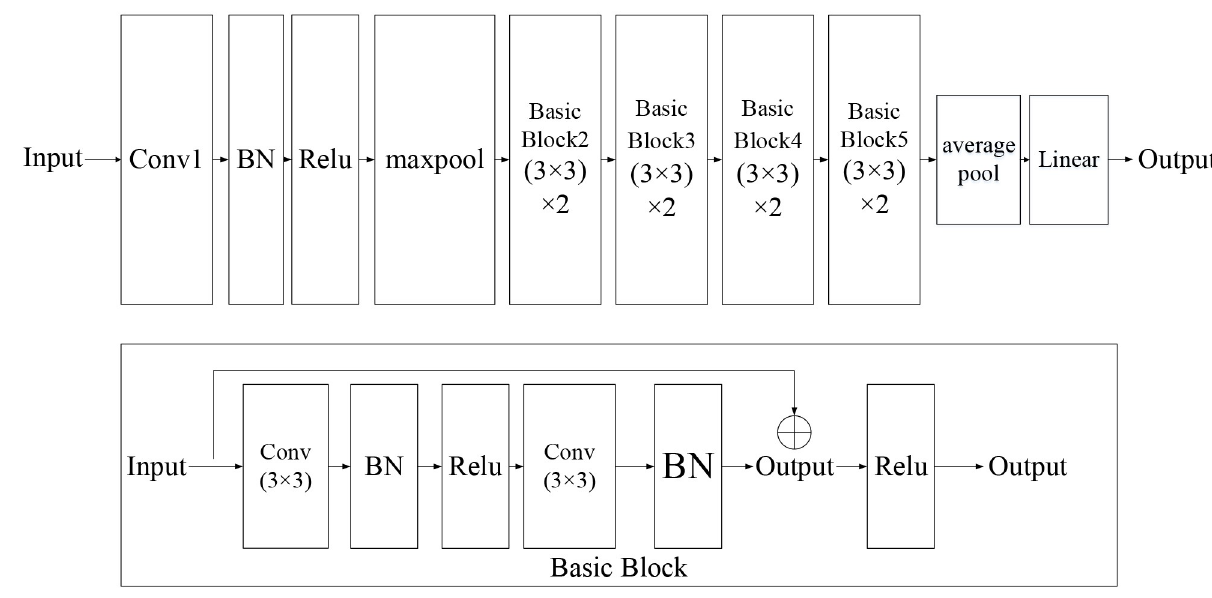
Fig 6. The structure of